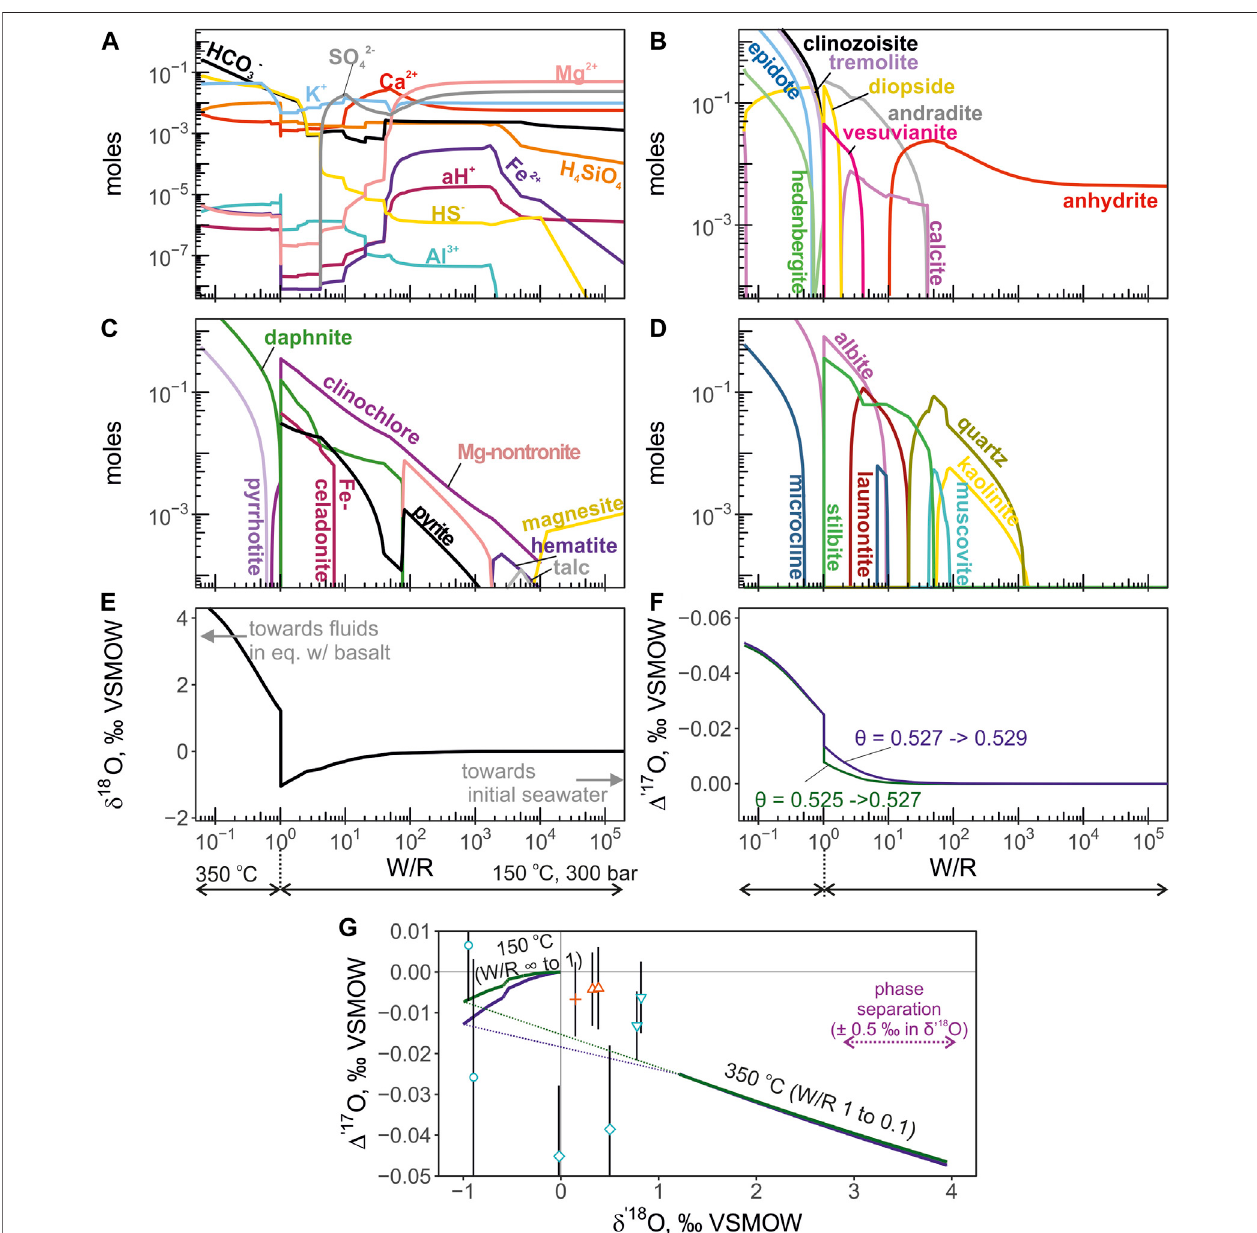
FIGURE 6 | The results of mineral-aqueous equilibrium calculation simulation seawater-basalt reaction at 150 ° C and 350 ° C, at 300 bars. The low-temperature (150 ° C) leg of reaction is calculated for W/R between 1 and in fi nity (pure seawater). The high-temperature reaction proceeds at W/R between < 0.1 and 1. Fluid was fractionatedfrom thesolidphasesatW/R (cid:1) 1.Thepanelsarepresented inthesamemannerisin Figure4 .Inpanel (F) the Δ ′ 17 Oofthe fl uid iscalculatedusingpairs of θ valuesof0.525and 0.527(green curve),and 0.527 and0.529 (blue). The fi rstvalue inthepair indicates the θ for low-temperaturereaction,and thesecond valueis for the high temperature reaction. Panel (G) shows the calculated trajectory of fl uid evolution and the compositions of endmember values in the δ ′ 18 O — Δ ′ 17 O coordinates.Notethenegative Δ ′ 17 Oshiftinthelow-temperaturereaction thatcanhelptoexplaincompositionofsome fl uids.Thedottedpartindicatesthetransitionfor low to high temperature accompanied by the change in fractionation